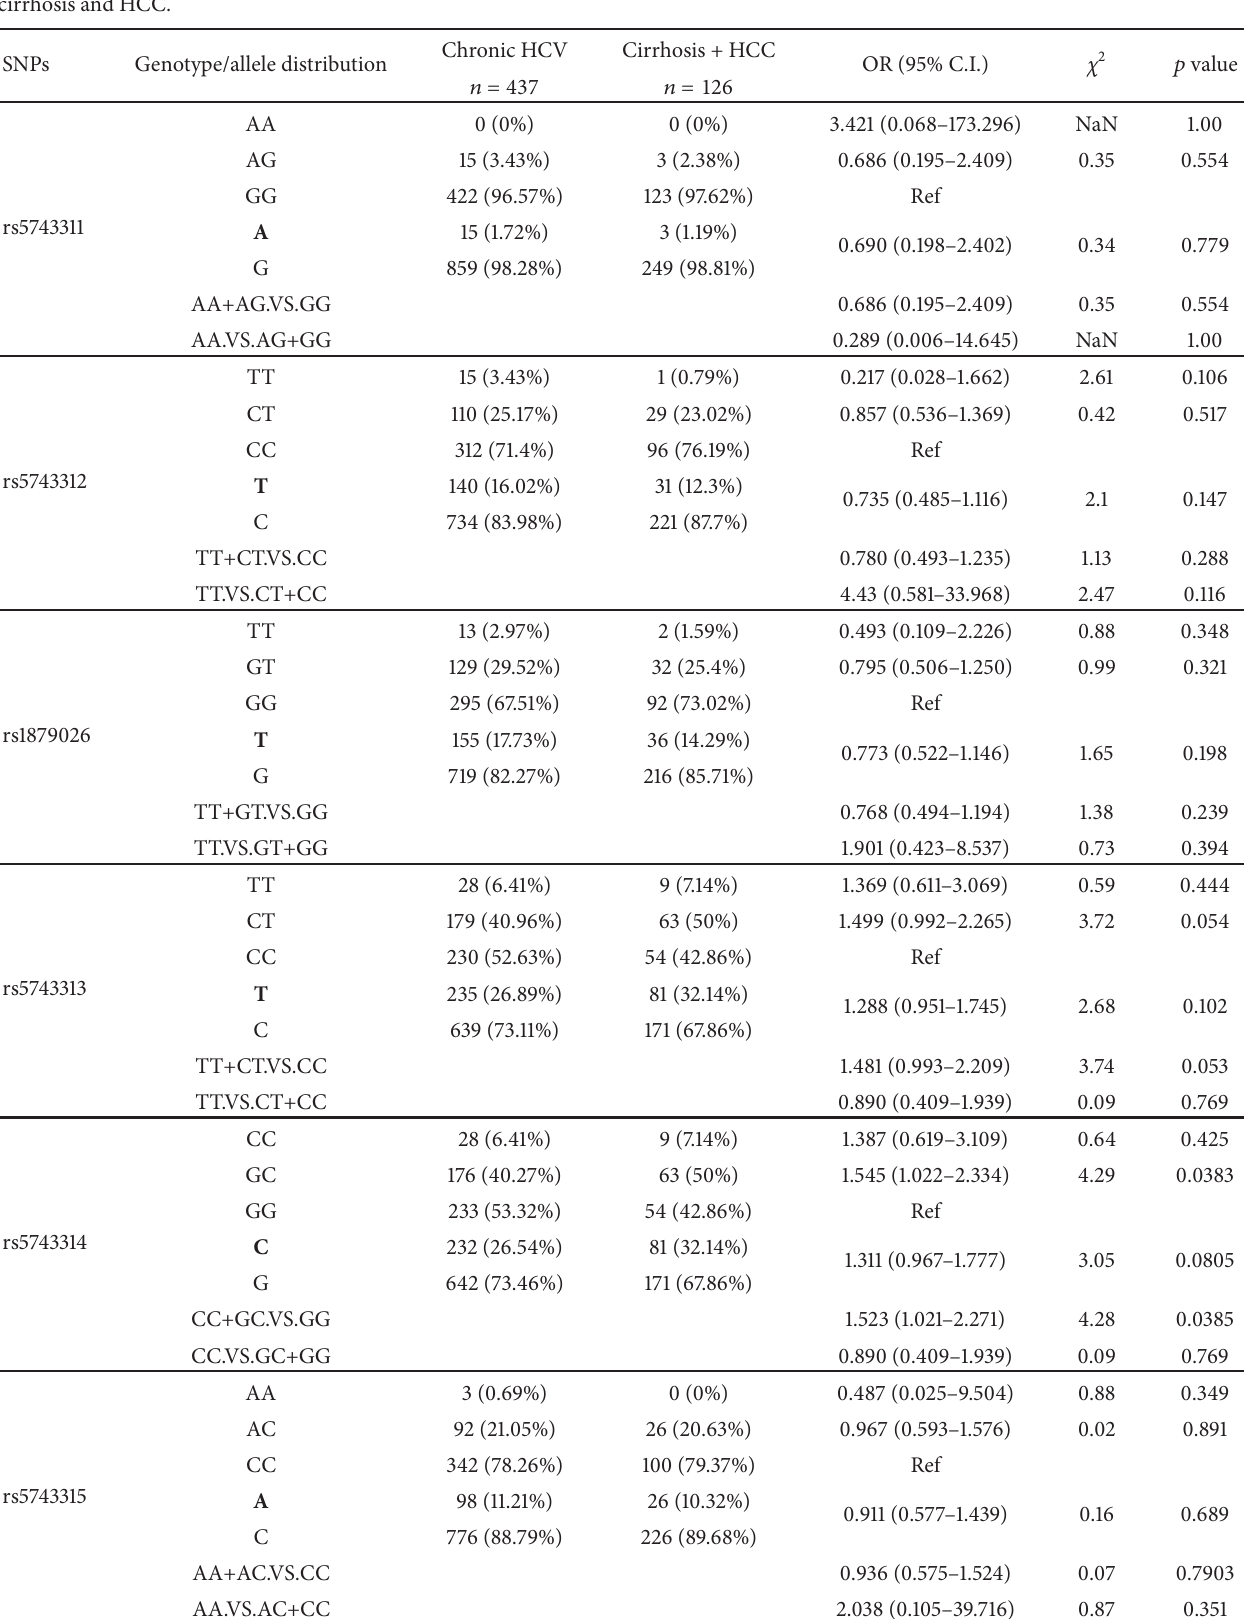
Table 5: Genotypic distribution of TLR3 gene polymorphisms when chronic HCV patients were compared to patients diagnosed with liver cirrhosis and